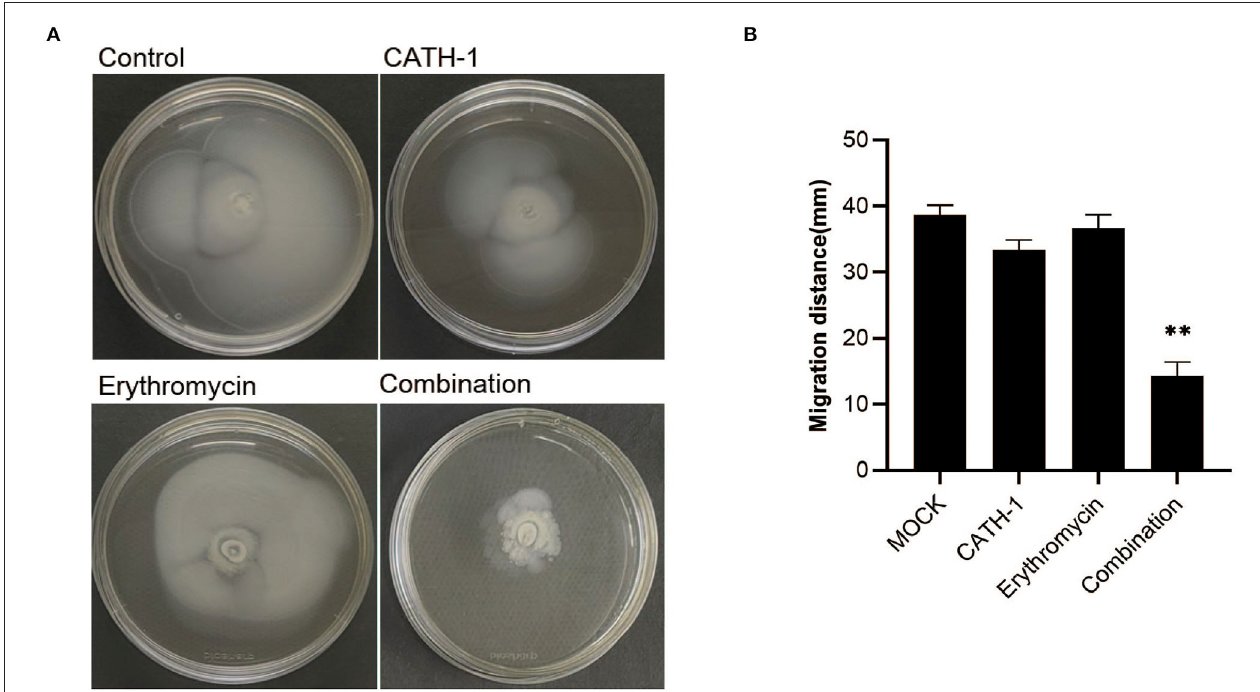
FIGURE 5 | The effect of CATH-1 and erythromycin combination on bacterial motility. Mid-logarithmic phase E. coli were treated with CATH-1, erythromycin, and CATH-1 + erythromycin, and then E. coli was inoculated in the center of the semisolid agar. The inoculated plates were incubated at 37 ◦ C for 18h. The motility image is shown (A) . The migration distance (mm) was measured (B) . Asterisks (*) indicate significant difference (* p < 0.05, ** p < 0.01).